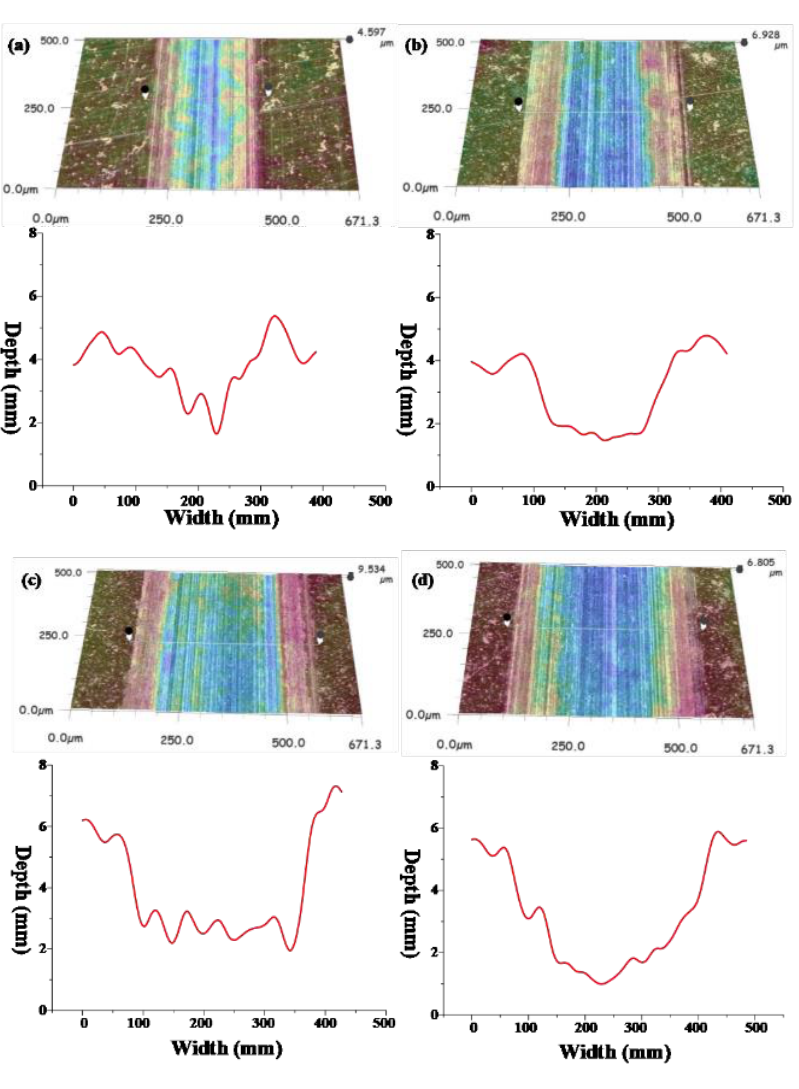
Figure 7. Three-dimensional morphologies and wear tracks of the wear scars corresponding to sample oil #2 under four different loads at the same sliding velocity: ( a ) 20; ( b ) 60; ( c ) 100; ( d ) 120 N.